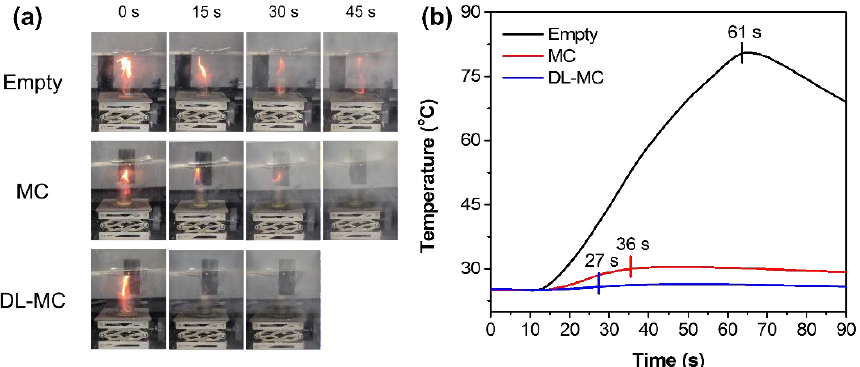
Figure 10. Laboratory scale fire suppression test; ( a ) Digital images of the fire suppression test, ( b ) Temperature deviation in the laboratory scale fire suppression test. ( b ) Temperature deviation in the laboratory scale fire suppression